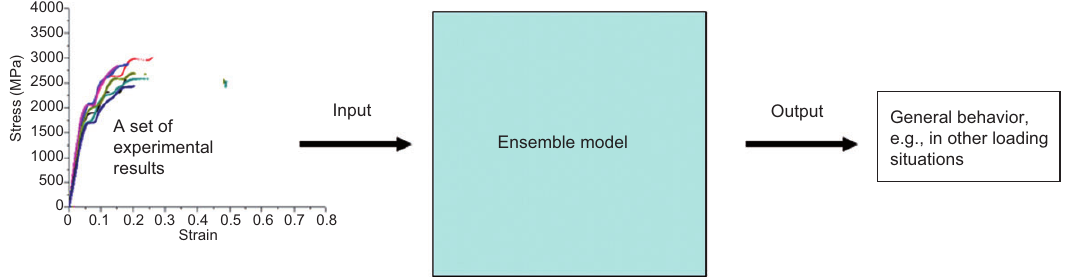
Figure 7 Materials mechanics framework for discrete plasticity.